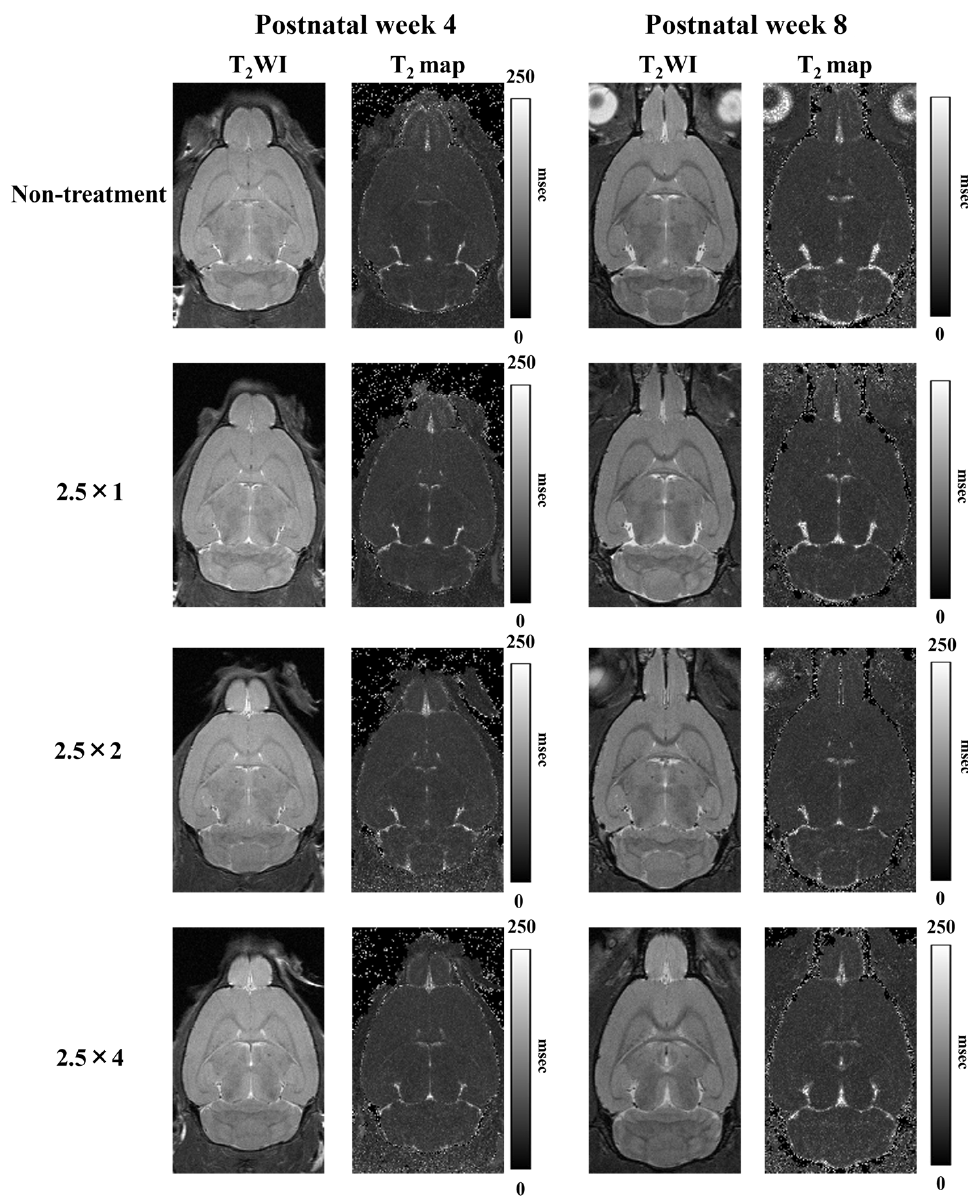
Figure 2. T 2 -weighted and T 2 map images at 4 and 8 weeks postnatally. The 10th slice of the 20 horizontal cross-sectional images acquired is shown.